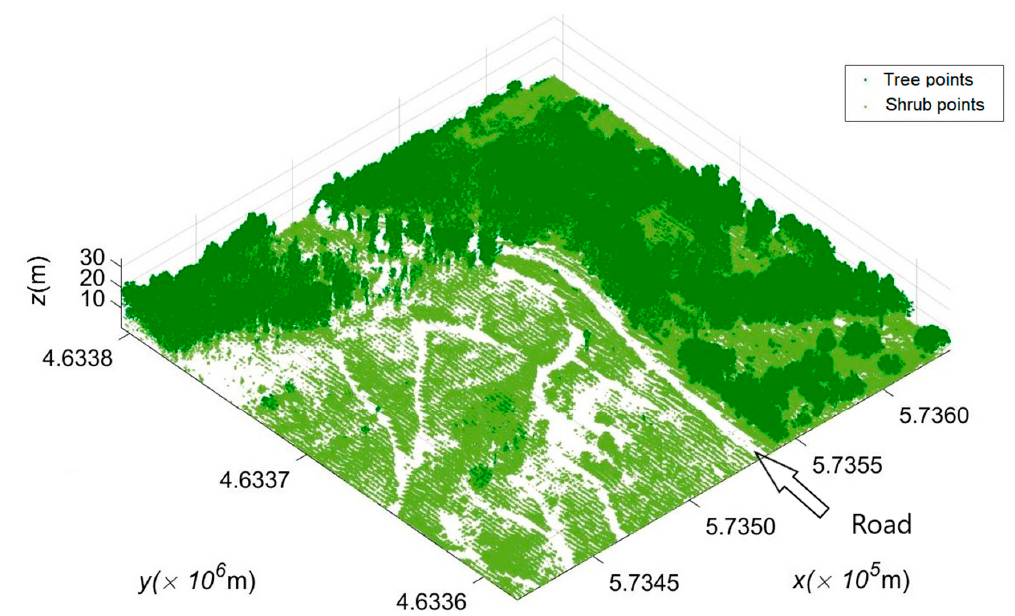
Figure 7. Vegetation points classification. Shrub points (light green) and tree points (dark green).